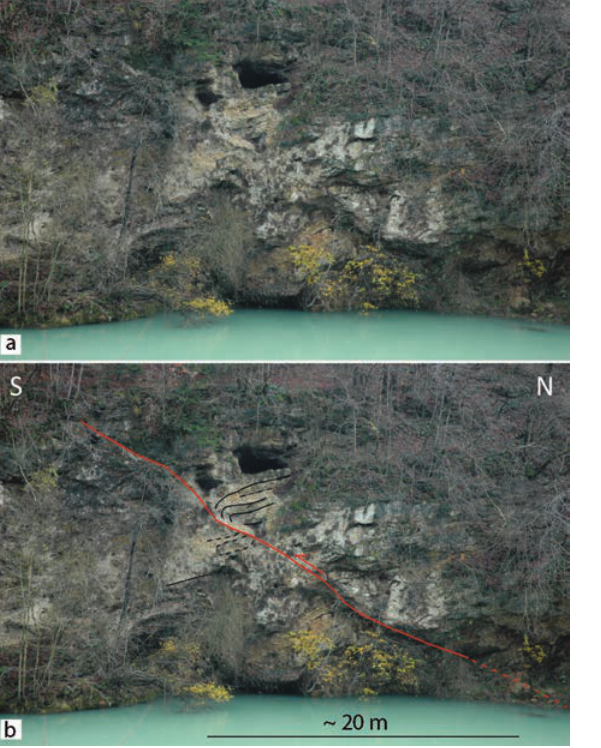
Figure 5. The fault plane of the southern Vodice fault exposed on the Sava River bank. (a) Picture of exposure. (b) Fault plane is indicated with red line and fault drag folds are indicated with black lines. The fault plane dips 35° towards N. See Figure 2a for location.